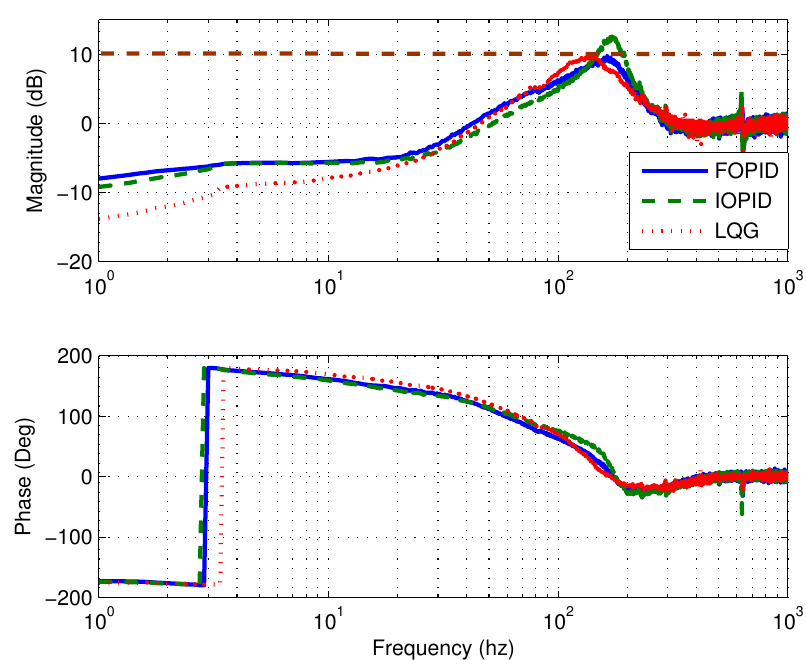
Figure 25. Bode plots of the lateral AMB sensitivity function at the motor side.